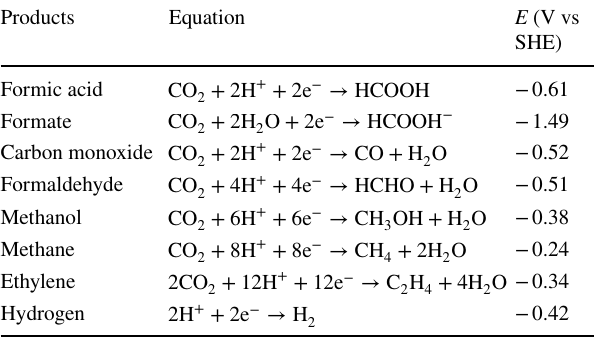
Table 1 Main products of ECR and the corresponding standard potentials (The equilibrium potential is at 25 °C and 101.325 kPa, and with proton activity of 1 mol L −1